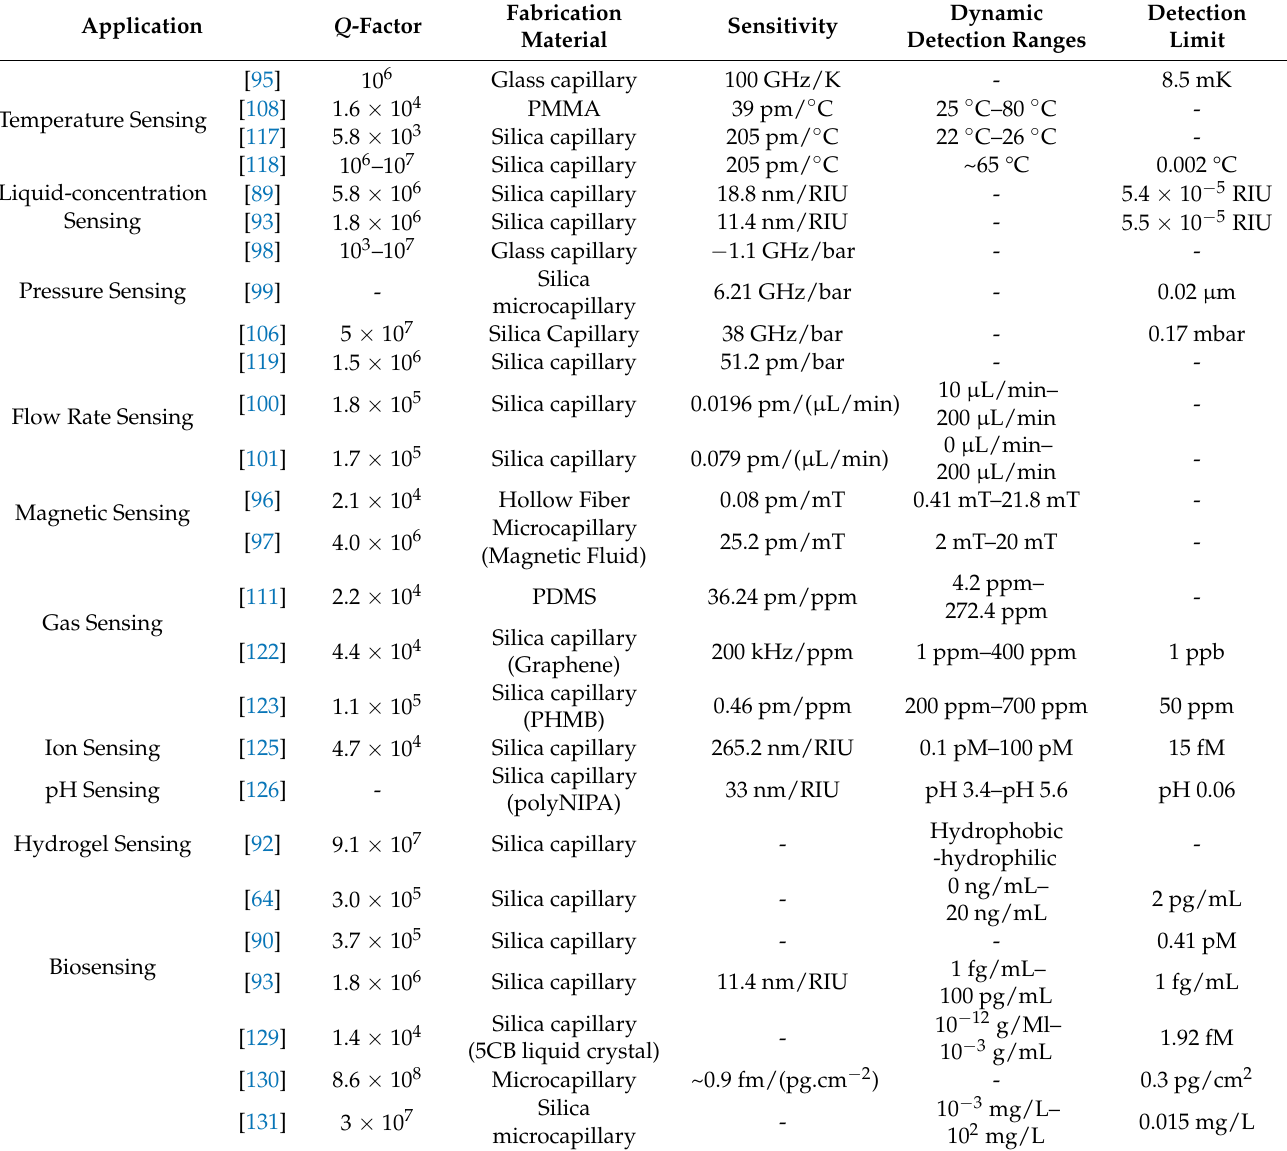
Table 1. Summary of different application of the microbubble